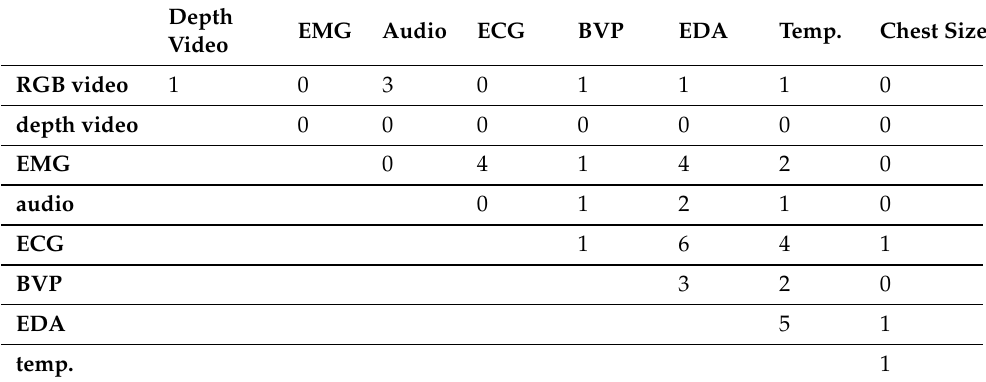
Table 15. Times when the two channels are analyzed